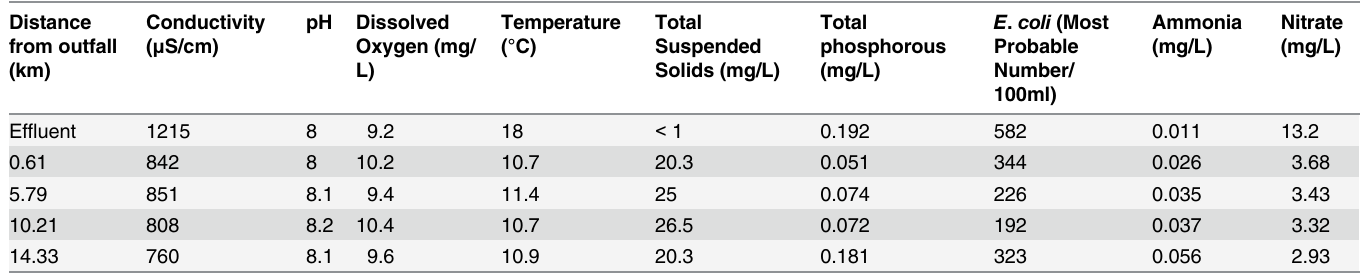
Table 3. Preliminary water quality test results used to determine site locations. Distance Conductivity from outfall ( μ (km)